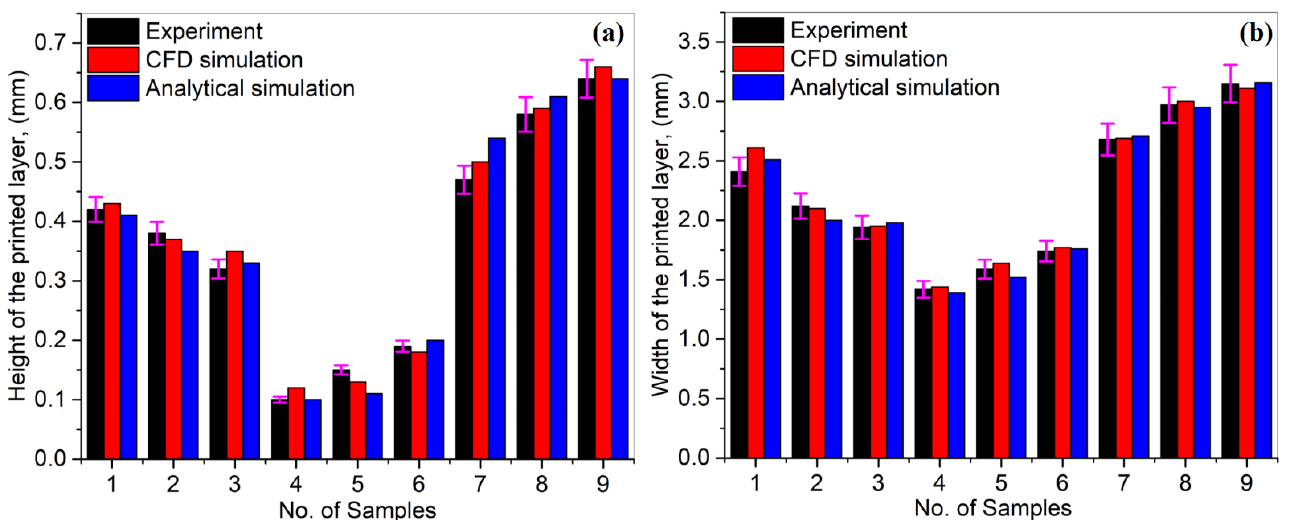
Figure 7. A comparison for (a) height and (b) width in the case of Ti6Al4V experiments and simulations. The cross-sections for liquid and solid transformations at various periods 0.03 s, 0.08 s, 0.15 s and 0.20 s are shown in Figure 8a–d. Conduction, convection and radiation are responsible for heat elimination from the LMD printed layer. The heat inside the metallic regime, (b) mushy (solid + liquid mixture) area and (c) solidified regime [72]. The